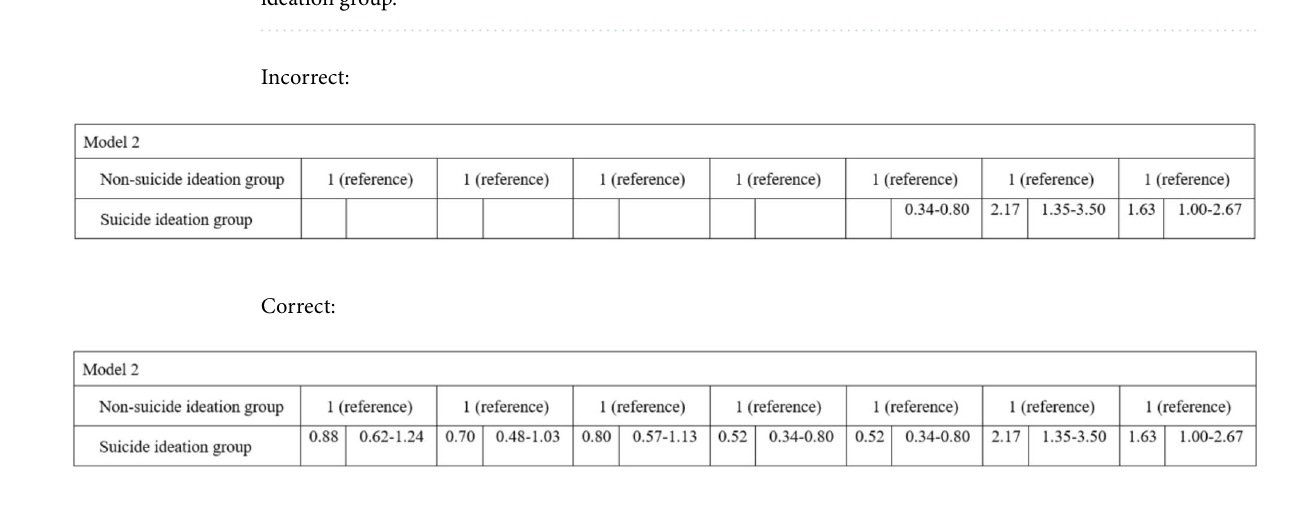
Table 1. Characteristics and preventive health behaviors among suicide ideation group and non-suicide ideation